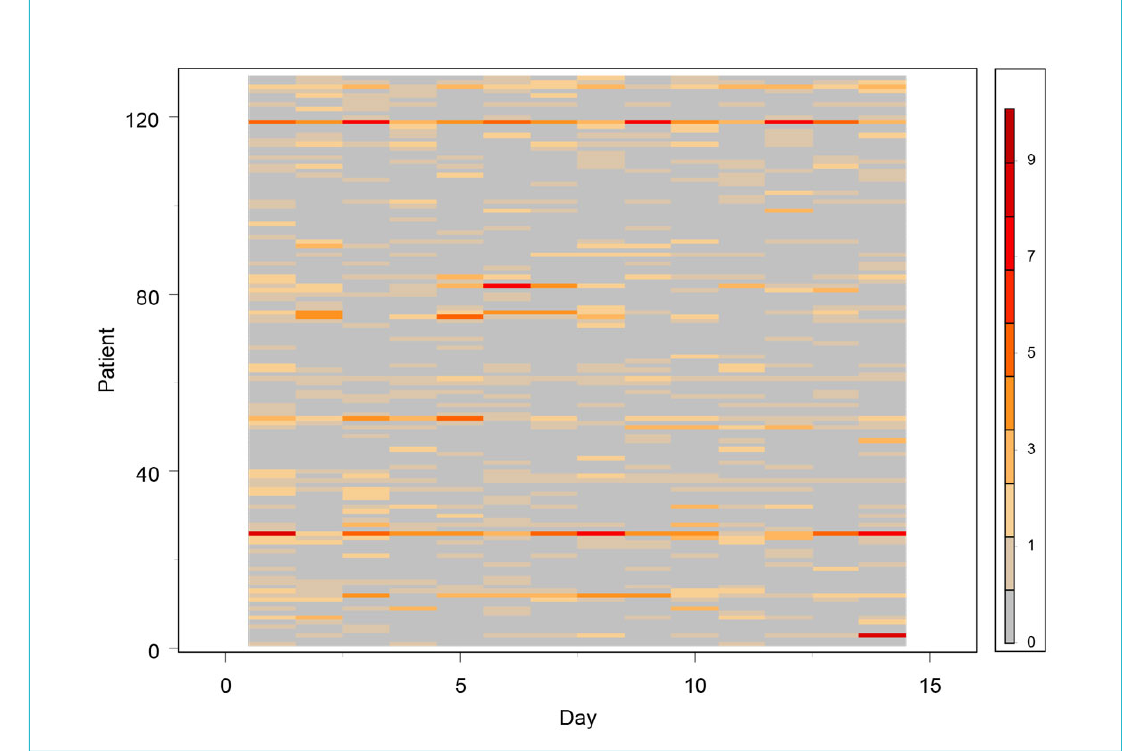
Figure 2: Contour plot of the number of nocturnal leg cramps per day, day by day for every patient (n =